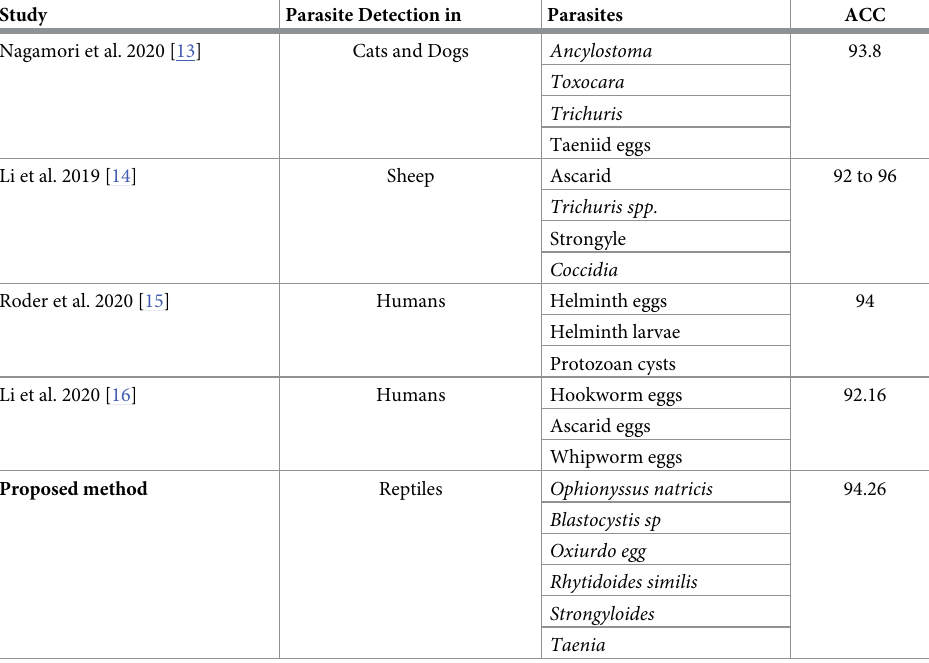
Table 6. Performance comparison with other fecal parasites identification